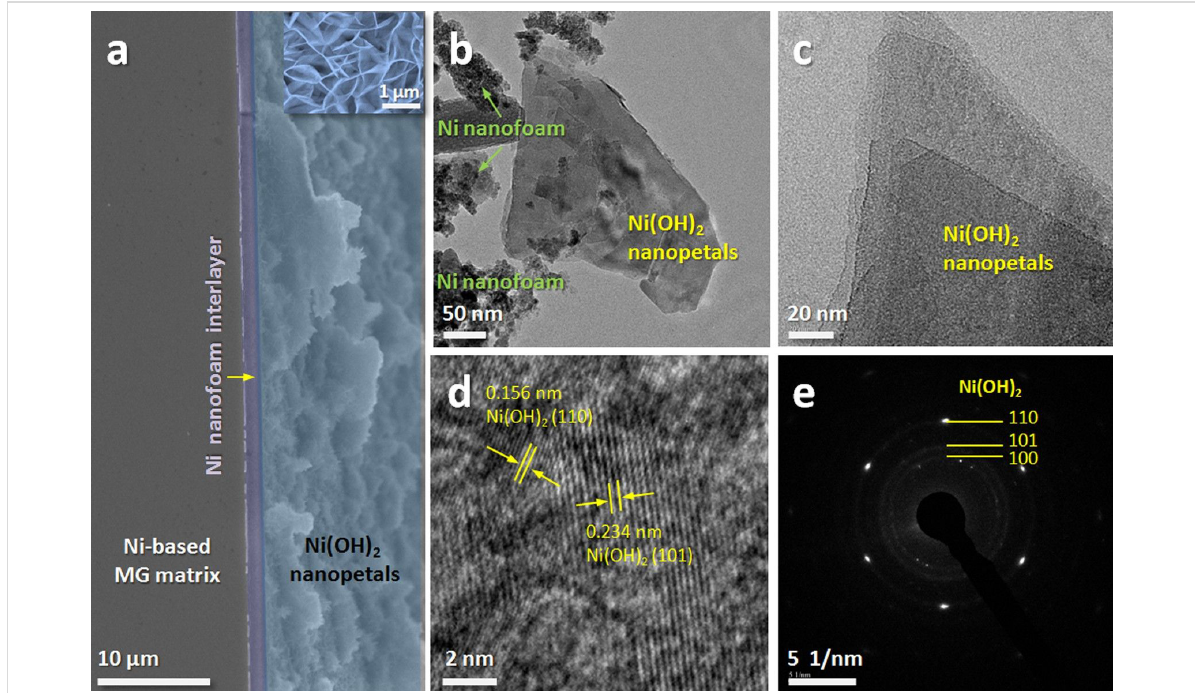
Figure 3: (a) Cross-sectional SEM images of the Ni(OH) 2 /Ni-NF/MG-5, the inset is a local high-resolution image; (b, c) low- and high-magnification TEM images; (d) HRTEM image; (e) SAED pattern of Ni(OH) 2 nanopetals.